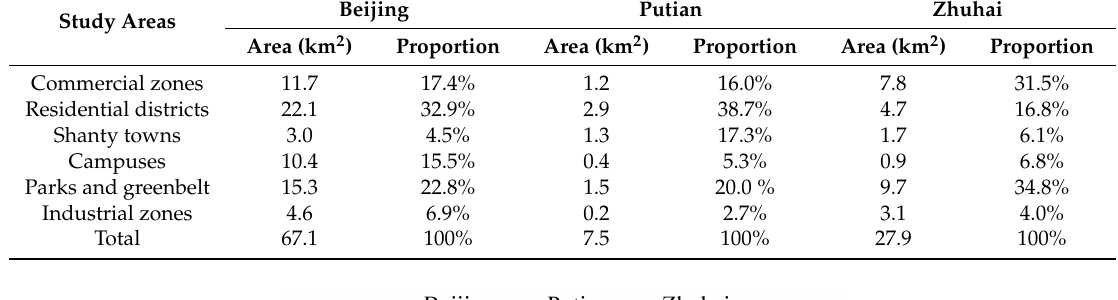
Table 7. Areas and proportions of diverse functional zones in the three study areas.